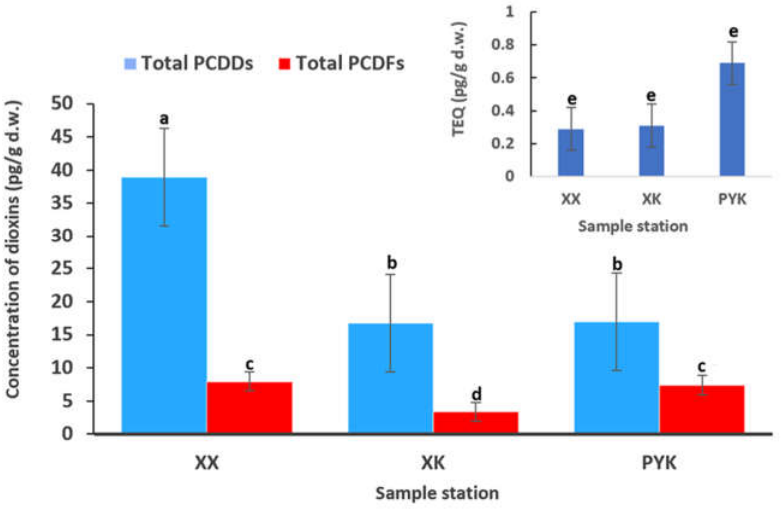
Figure 2. The concentrations of PCDD, PCDF and TEQ (WHO, 2005) in different areas of the Xiangxi River. TEQ was at the top-right corner; the dioxin concentration in the downstream area was higher, but the TEQ in the upstream was higher. Different letters indicated significant differences between sample stations.